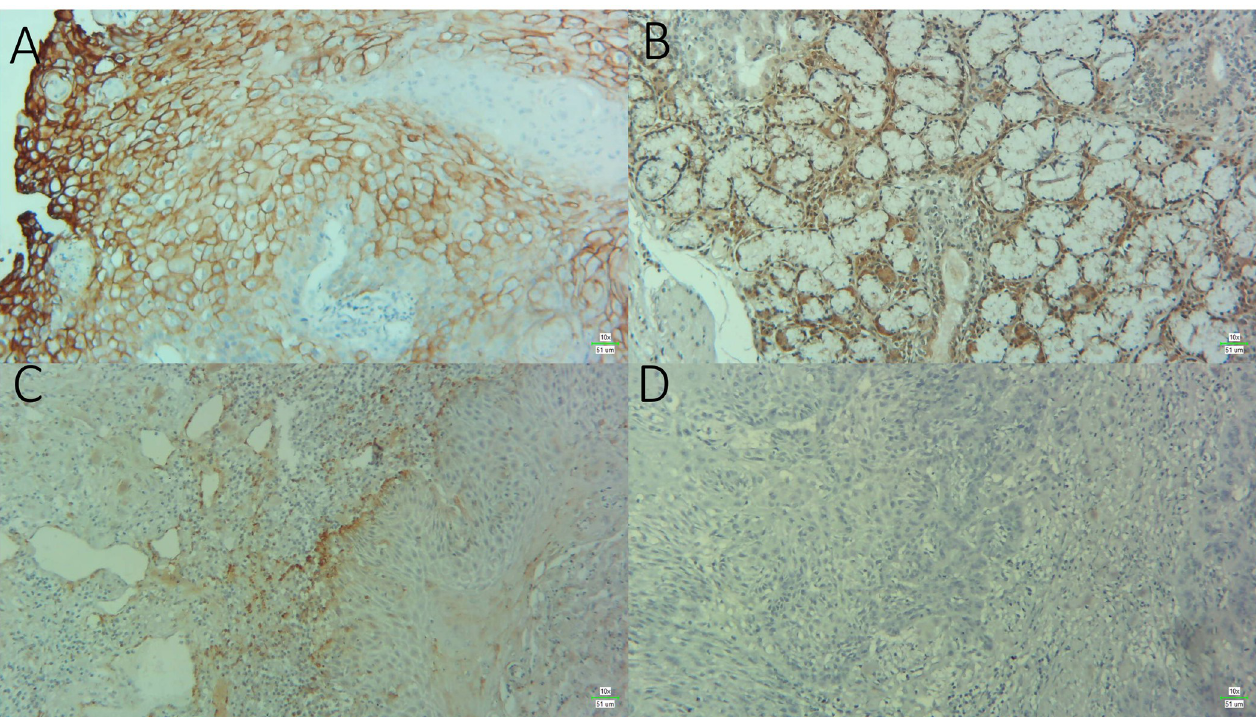
Fig 1. Photomicrograph of (A) Her-2 showing strong membranous positivity (B) AR showing nuclear positivity (C) ER showing nuclear positivity and (D) PR negative staining in OSCC specimens [Magnification × 10].